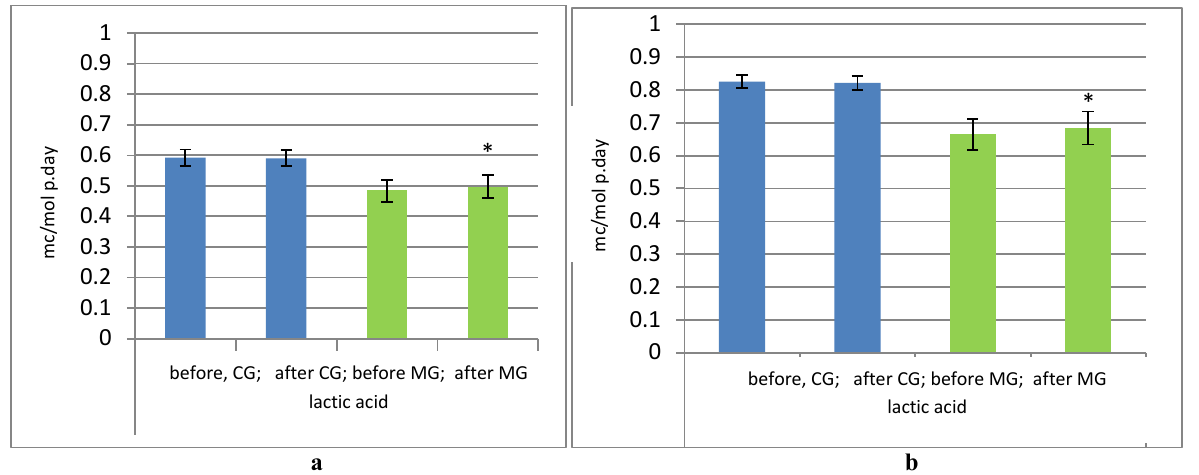
Fig.8. Indicators of bio-chemical monitoring by excretion of lactic acid before and after experiment in mixed cluster (of main and comparative groups): a) by bicycle stress test «Vita maxima»; b) by results of control special tests. (** -р≤ 0.05). CG – comparative group, MG – main group. Urea indicators are similar (see fig.